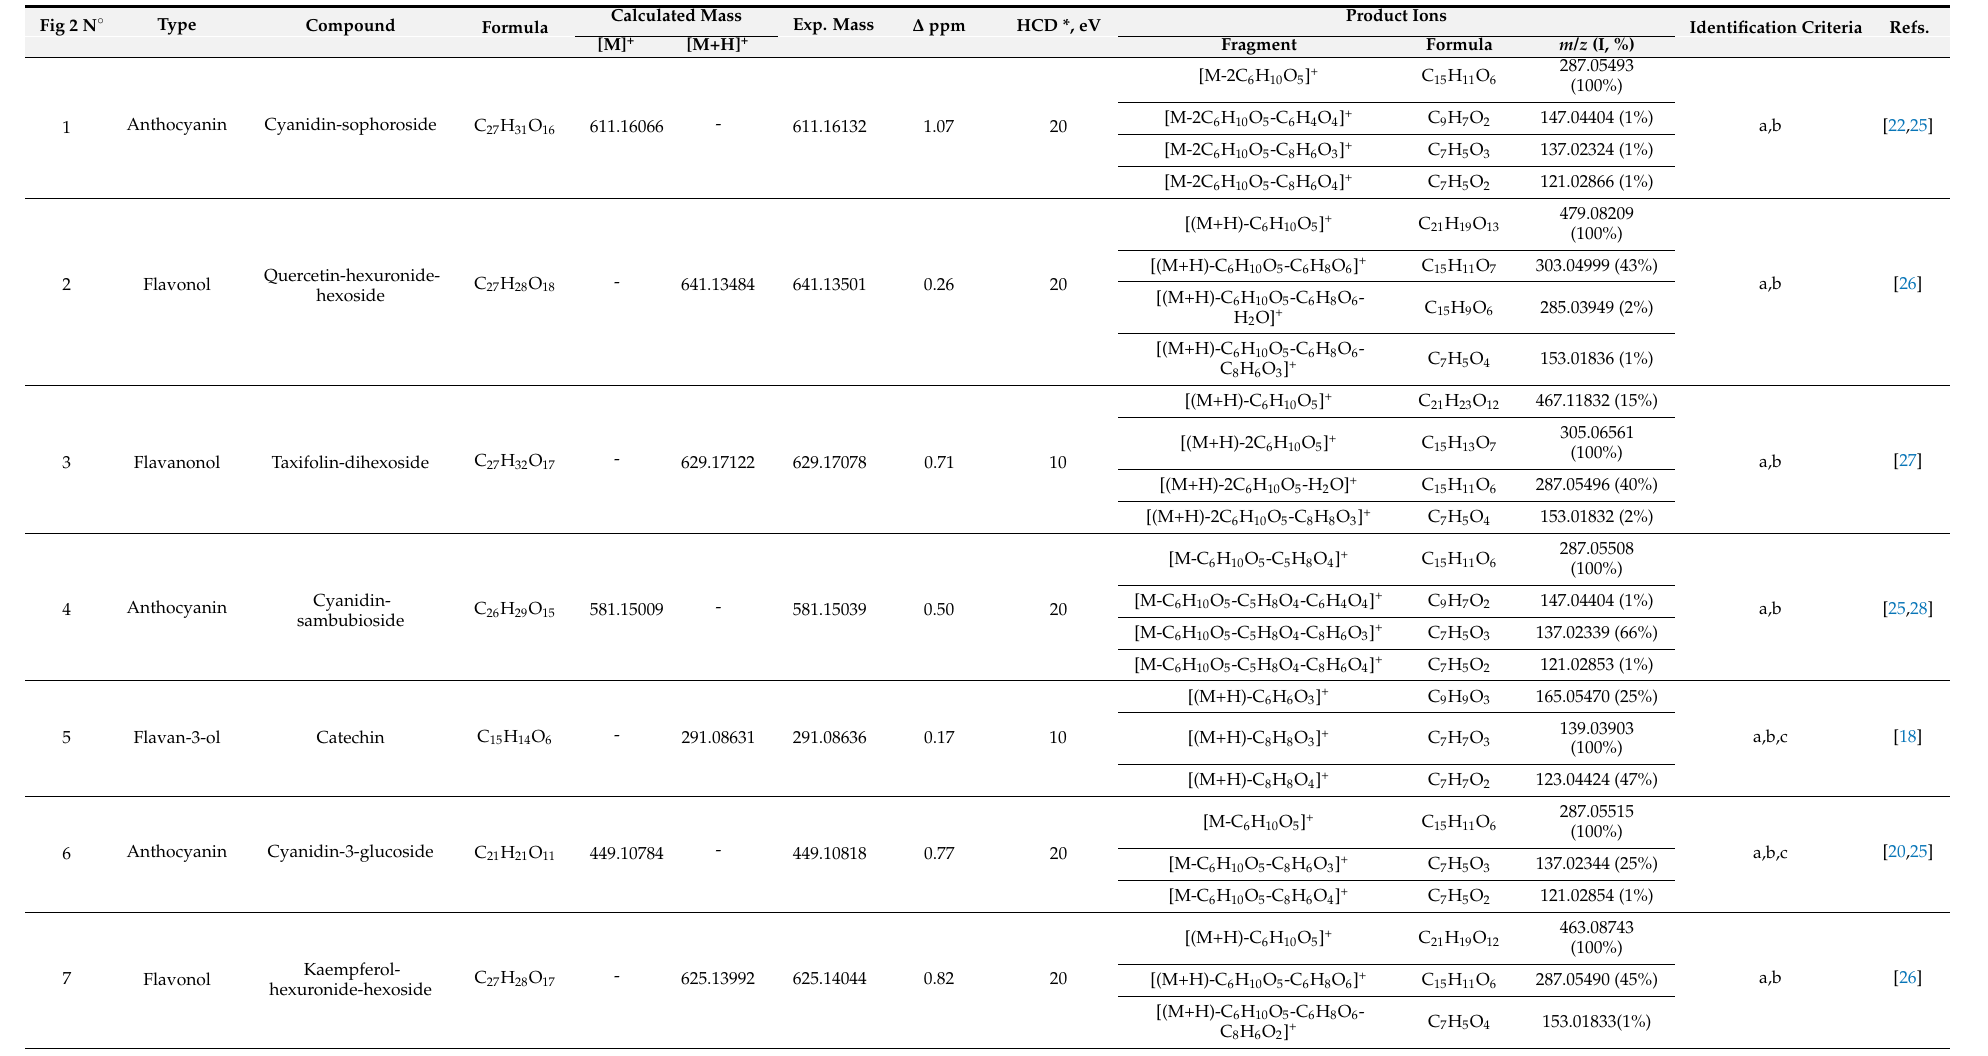
Table 1. Exact masses obtained by UHPLC-ESI+-Orbitrap-MS of [M] + ions or [M+H] + protonated molecules of flavonoids found in H. rosa-sinensis flower extracts. Fig 2 N